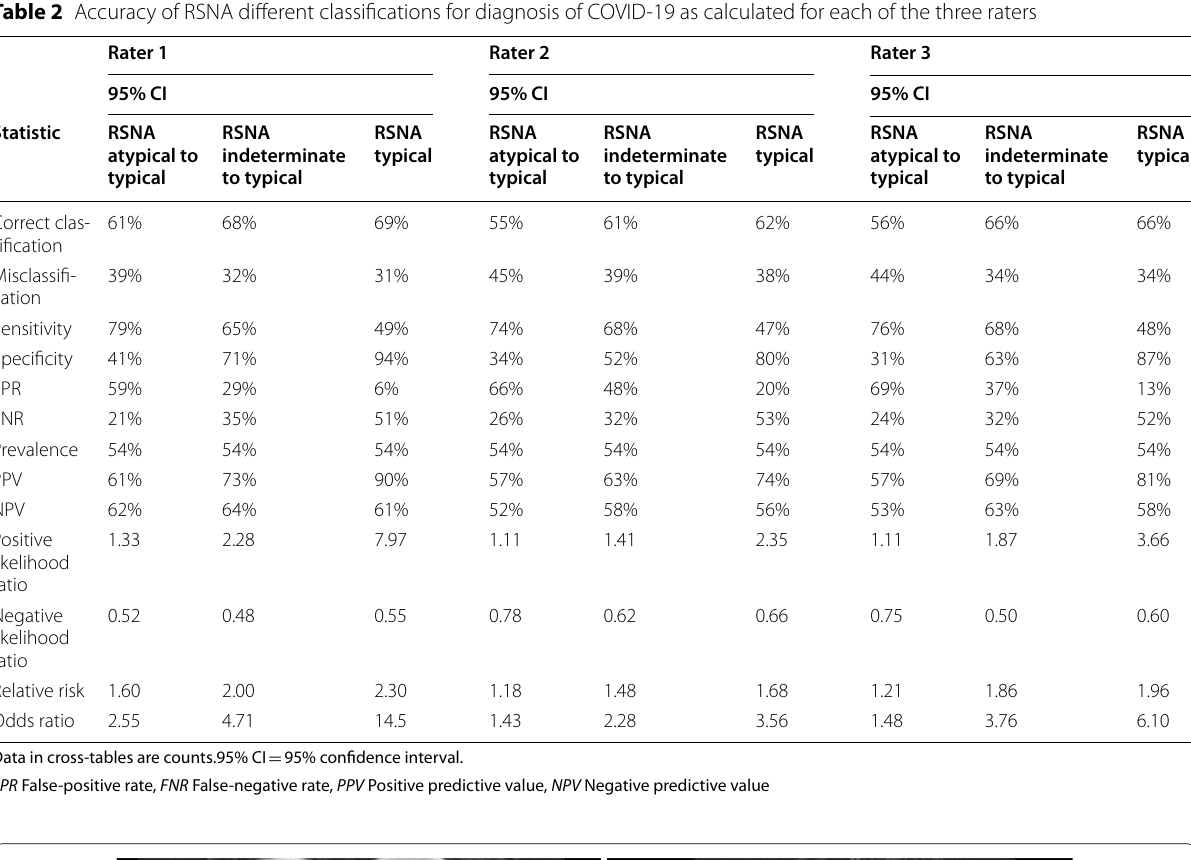
Table 2 Accuracy of RSNA different classifications for diagnosis of COVID‑19 as calculated for each of the three raters